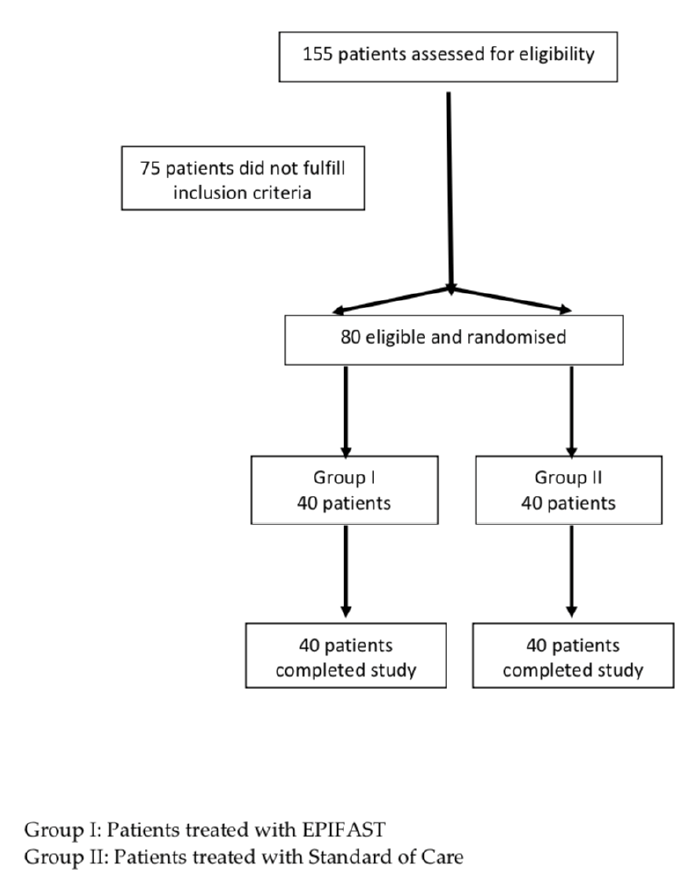
Figure 1. Flowchart showing patient randomisation.